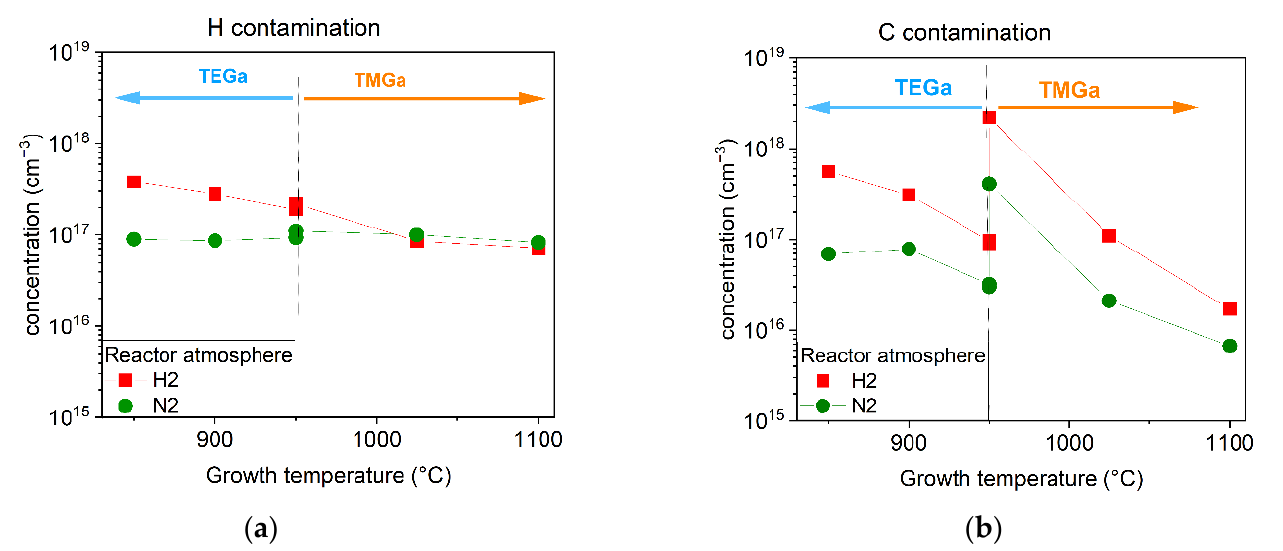
Figure 10. Concentration of ( a ) hydrogen and ( b ) carbon contamination measured by SIMS on layers prepared on multi-layered samples with technological parameters as defined in Table 1.